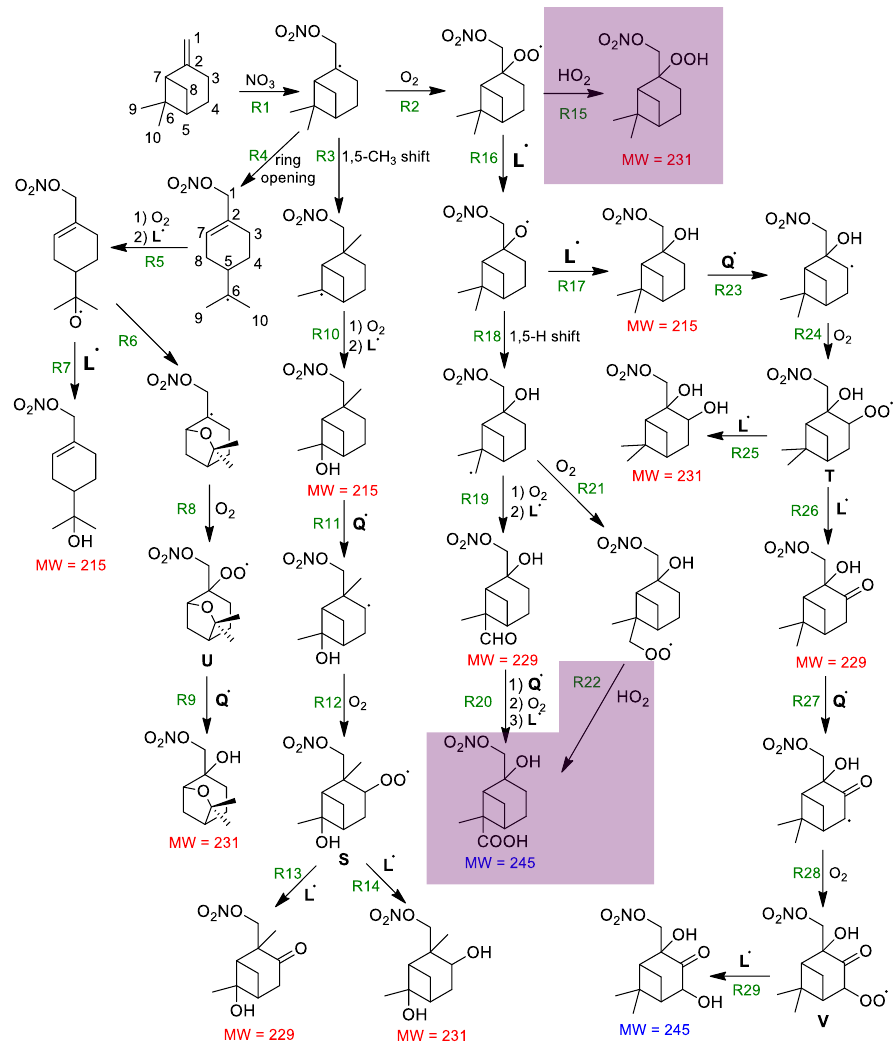
Figure 8. Generation of gas-phase species with molecular weights (MW) of 215, 229, and 231amu detected by CIMS (red font), aerosol species with MW = 245amu in filters analyzed by UHPLC-MS (blue font). Reaction numbers are given in green font and reaction with (cid:113) generic radical Q (e.g., NO 3 , RO 2 ) is used to symbolize any species abstracting hydrogen atoms. Reactions which can be accomplished by any of the radicals present (RO 2 , HO 2 , NO 3 , etc.) are symbolized by reaction with generic radical L dominant pathway are highlighted in